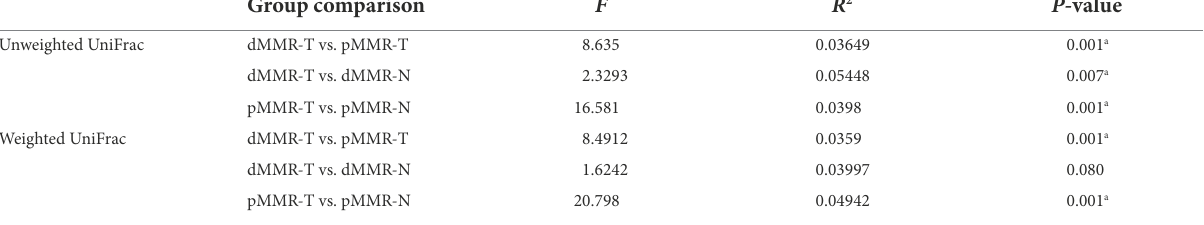
TABLE 4 Microbial beta-diversity index